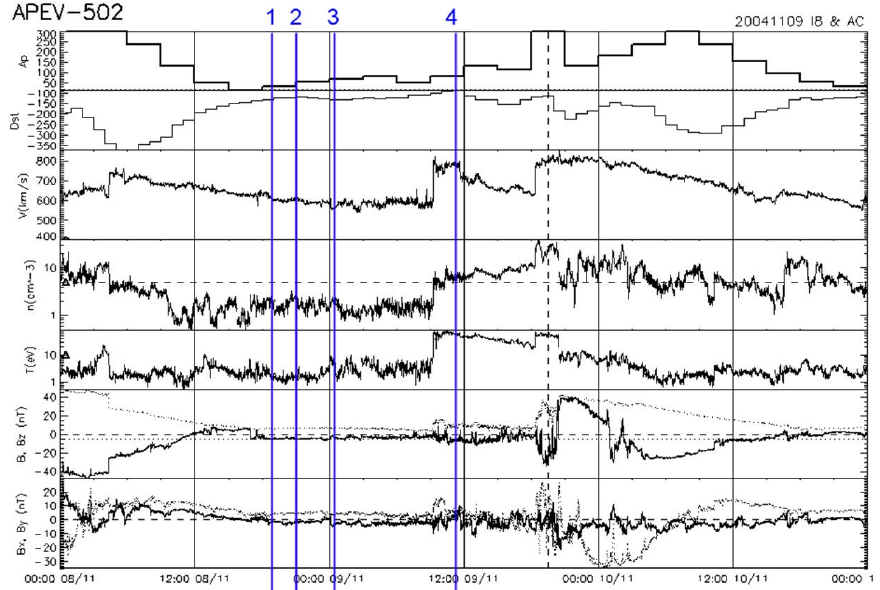
Figure 11. Time variations of solar wind, IMF parameters and geomagnetic indices Ap and Dst from November 8 to November 11, 2004 (http://dbserv.sinp.msu.ru/apev/).